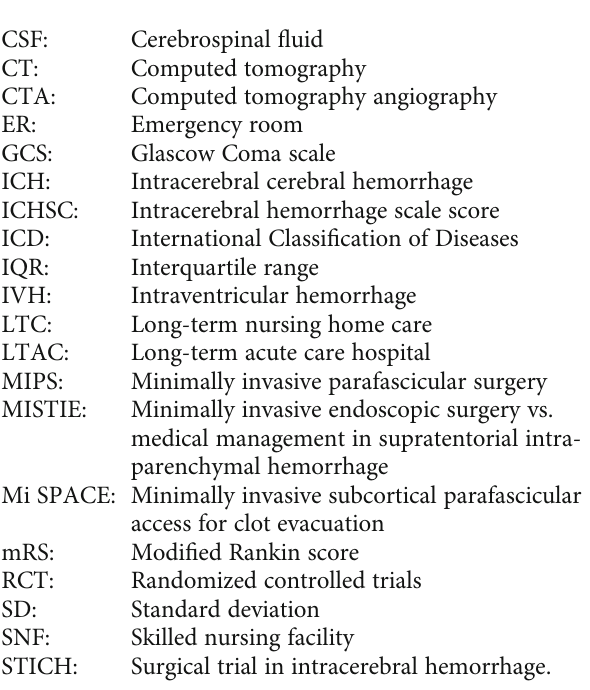
Table S1: logistic regression results for inpatient